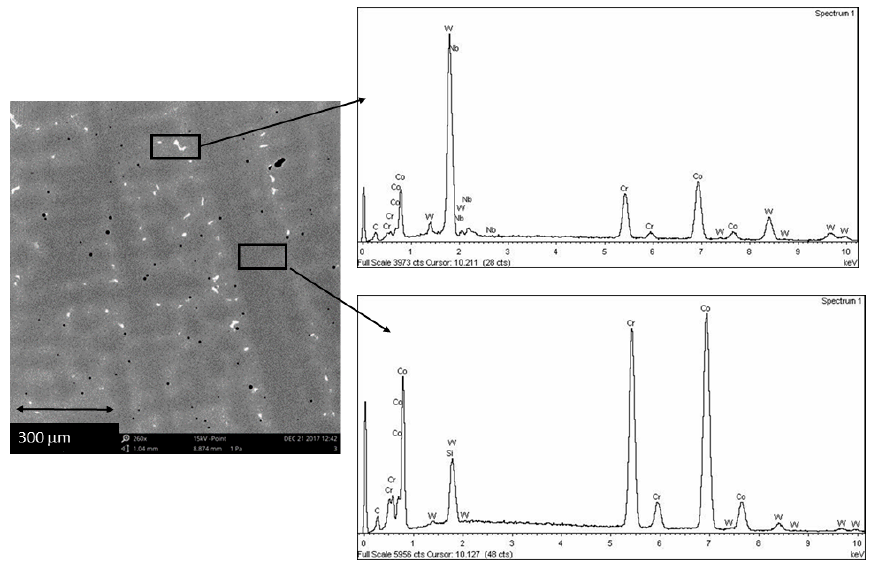
Figure 4. SEM micrographs of different microstructures obtained as a function of the manufacturing method used. ( a ) Computer-aided design and manufacturing (CAD-CAM) milling, ( b ) laser sintering, and ( c ) casting.